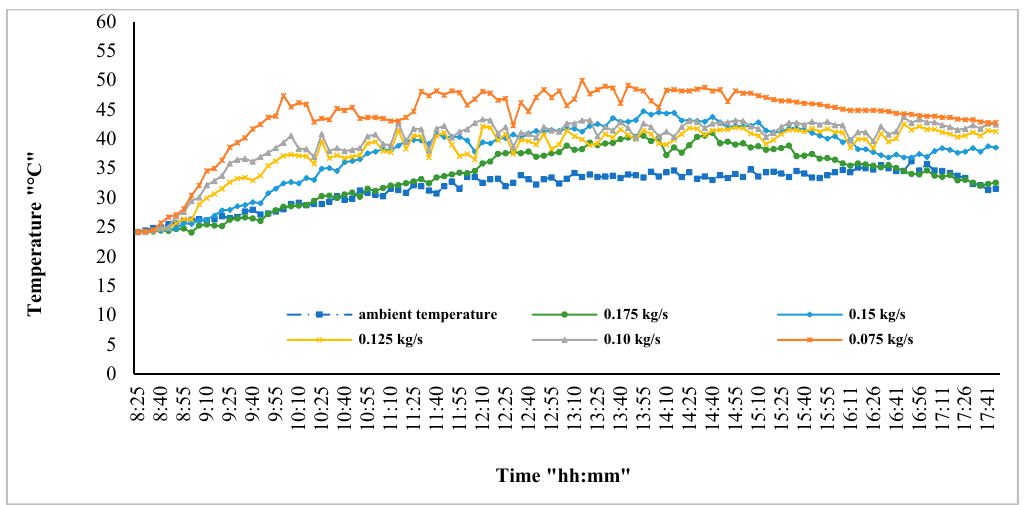
Figure 5. Water mass flow rate effect on PV module surface temperature.